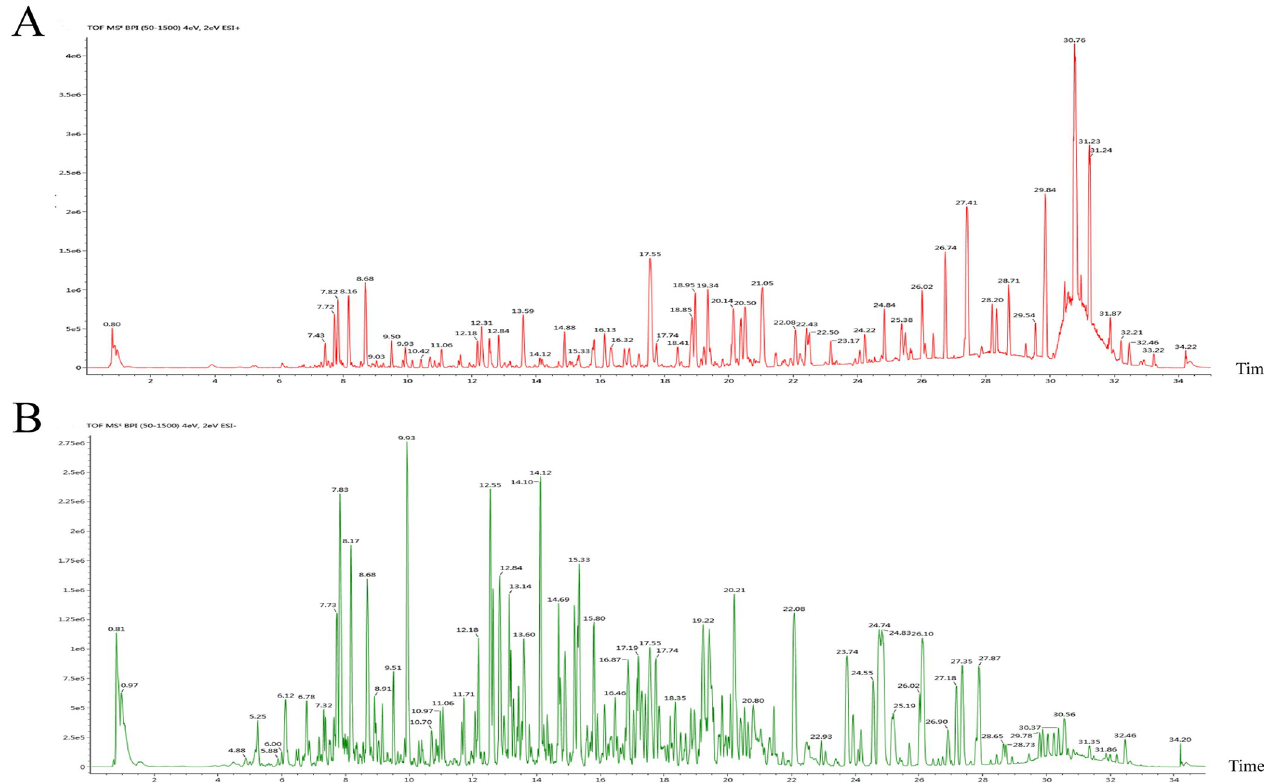
Fig 2. UPLC–Q–TOF/MS analysis of CZX. Total ion current base peak intensity (BPI) chromatogram in (A) positive mode and (B) negative mode.